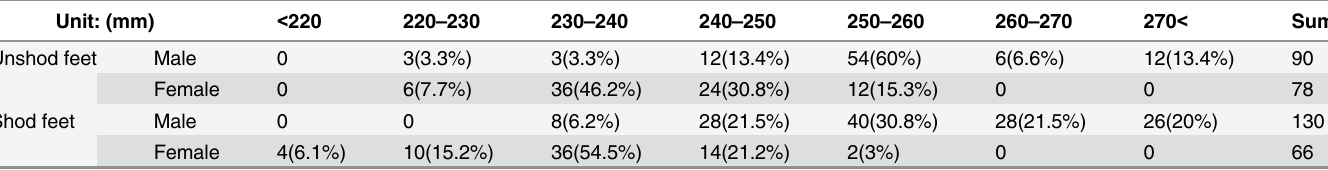
Table 2. The length sample distribution of unshod feet and shod feet.